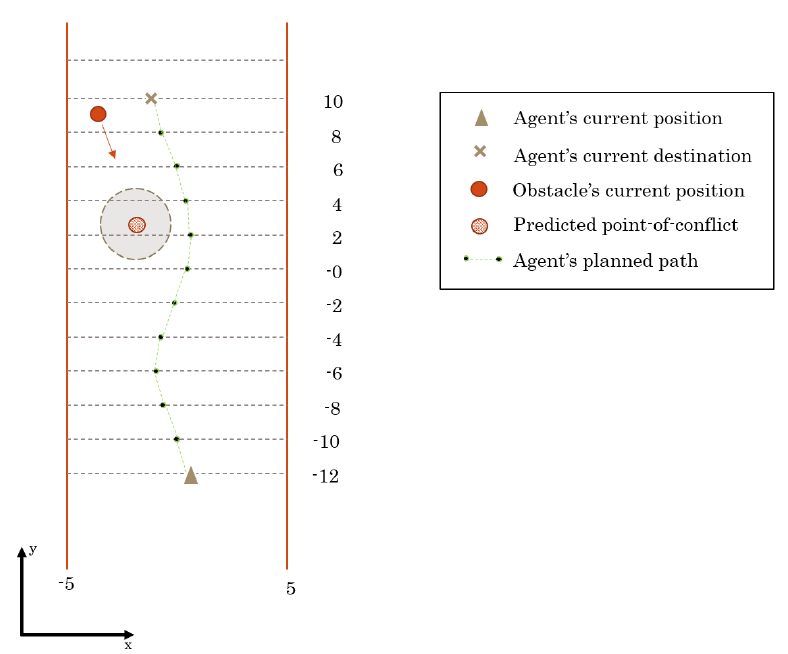
Figure 3. Path-planning environment